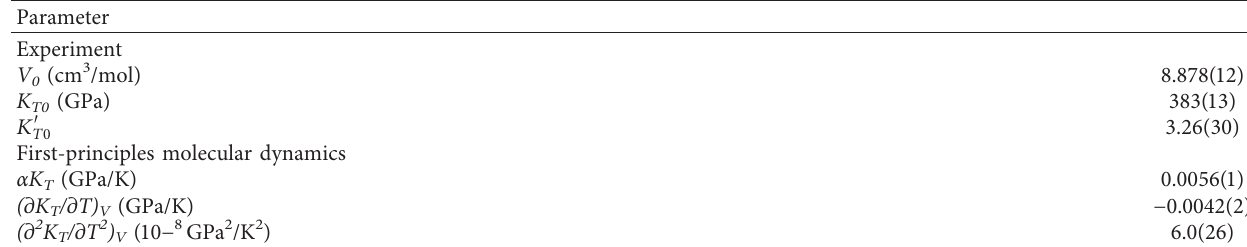
Figure 2: Experimental data on lattice parameters and volume of Re at 300K. Circles represent the lattice parameters and unit cell volumes of Re with a hexagonal structure, obtained from high-pressure experiments. Dashed lines show the fitted curves. Solid lines show the calculated lattice parameters and unit cell volumes at 300K. Table 1: Thermoelastic parameters of